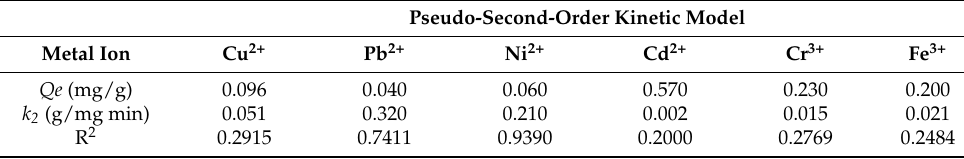
Table 4. Pseudo-second-order constants for adsorption of the MX+ onto MS.